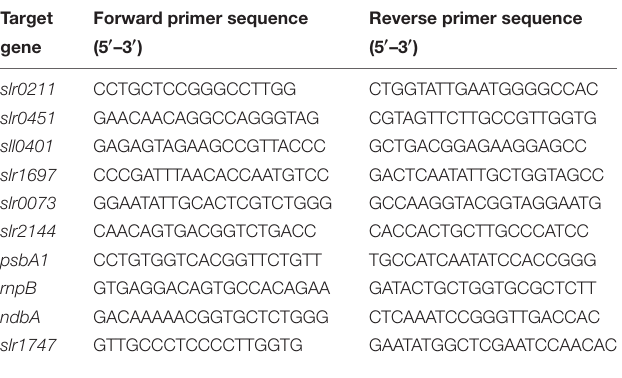
TABLE 1 | Primer sequences for quantitative real-time